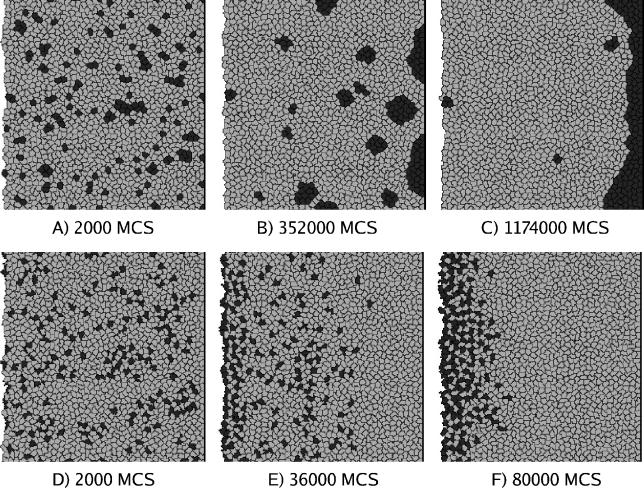
Snapshots of Two Typical Runs That Show Adhesion-Based Cell SortingThe upper panels show directional cell sorting of the cells with high surface energy towards the front (in the direction of the chemotaxis), while in the lower panels the cells, which have low surface energy, sort to the back.(A–C) Jl,l = 5, Jd,l = 9, Jd,d = 8 (γ = 2.5).(D–F) Jl,l = 5, Jd,l = 3, Jd,d = 3 (γ = −1).Other parameters as in Figure 1.